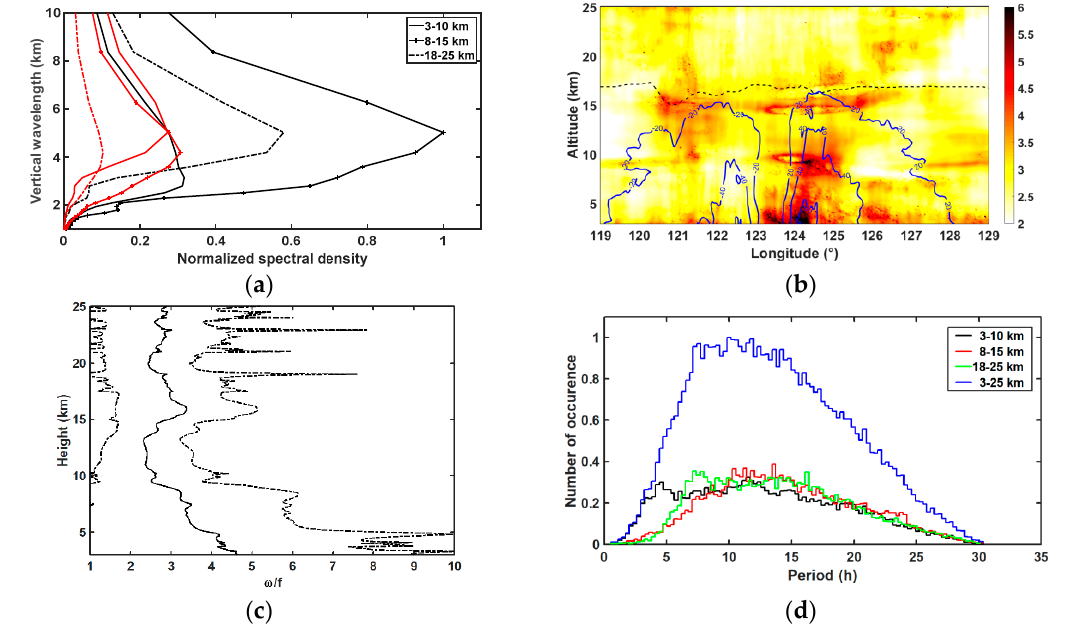
Figure 13. ( a ) Normalized-spectral energy distribution of vertical wavelengths at heights of 3–10 km (solid), 8–15 km (plus) and 18–25 km (dash-dot) in zonal (black) and meridional (red) wind perturbations at latitude 23° N. ( b ) Longitude–altitude distribution of normalized intrinsic frequencies ω /f with contours of tangential wind (blue solid) and tropopause height (dashed) at latitude 23° N. ( c ) Normalized intrinsic frequencies ω /f (solid) and standard deviation (dashed) as a function of altitude at latitude 23° N. ( d ) Normalized distributions of occurrence of periods at heights of 3–10 km, 8–15 km, 18–25 km and 3–25 km at latitude 23° N. The CWT was applied on a 6 min time series of normalized dynamical parameters (zonal,